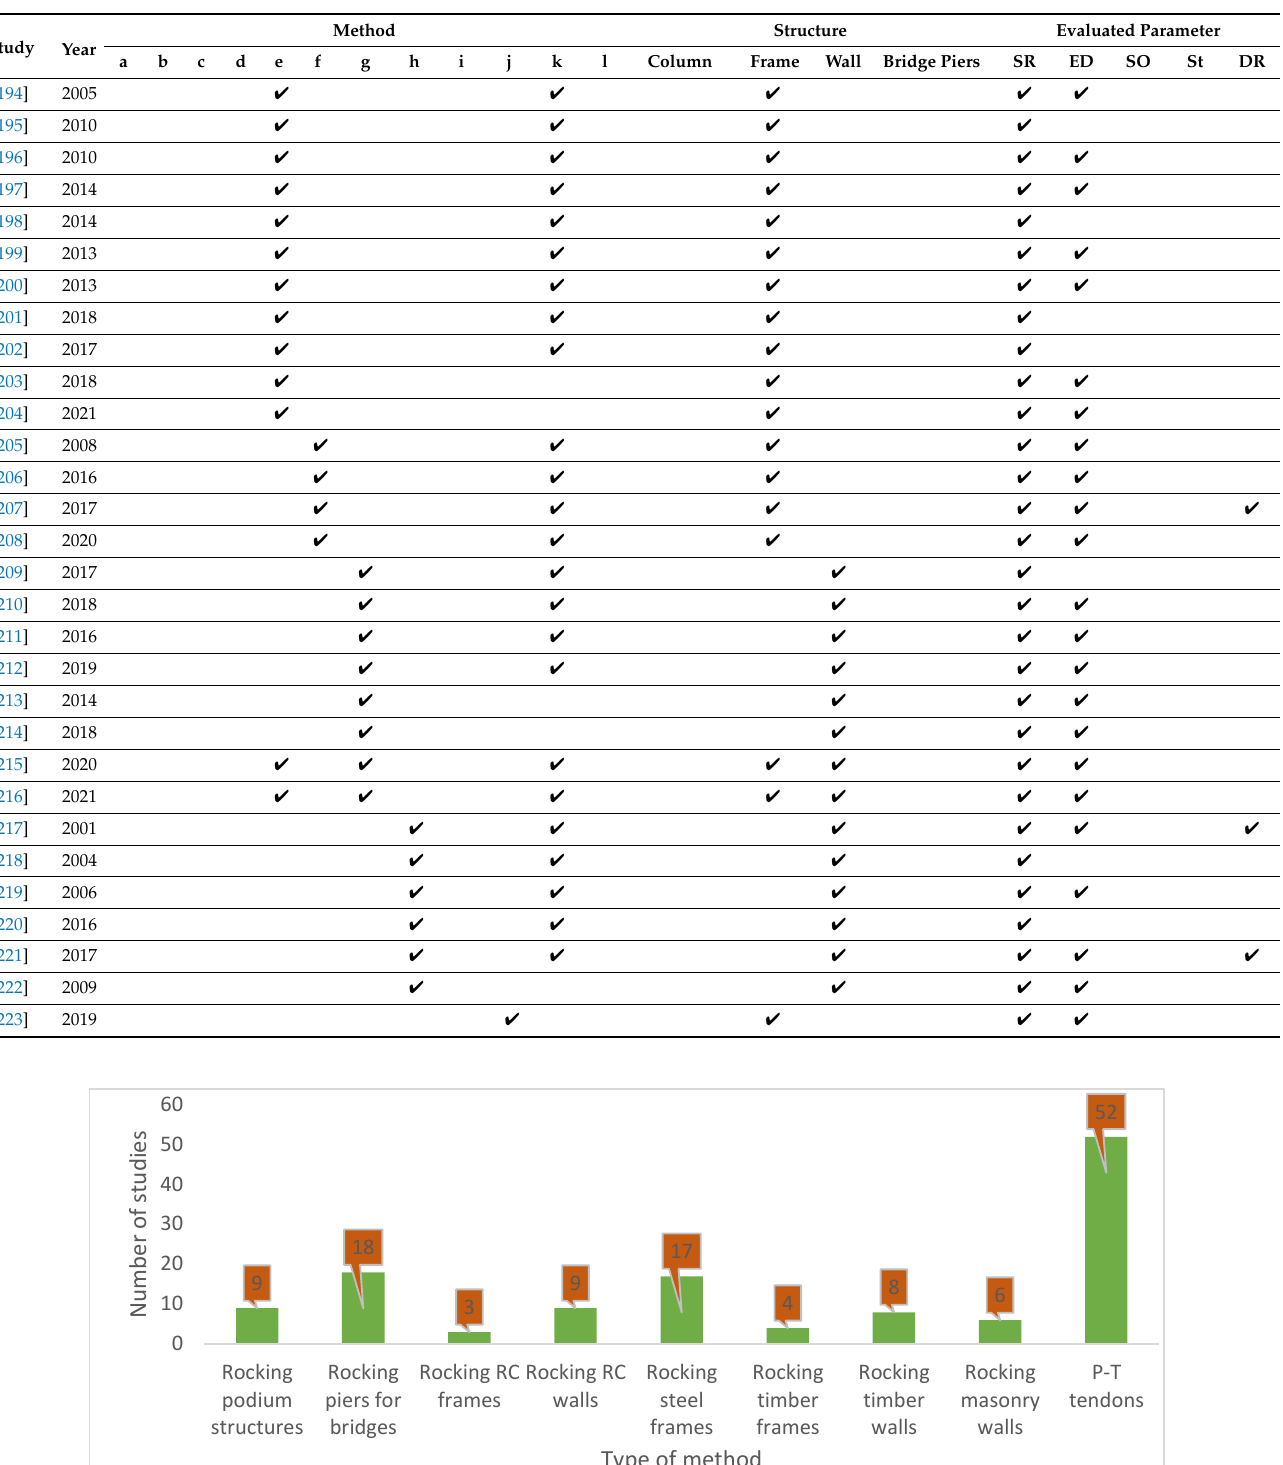
Figure 10. Visualization of the summarized research based on the method discussed.